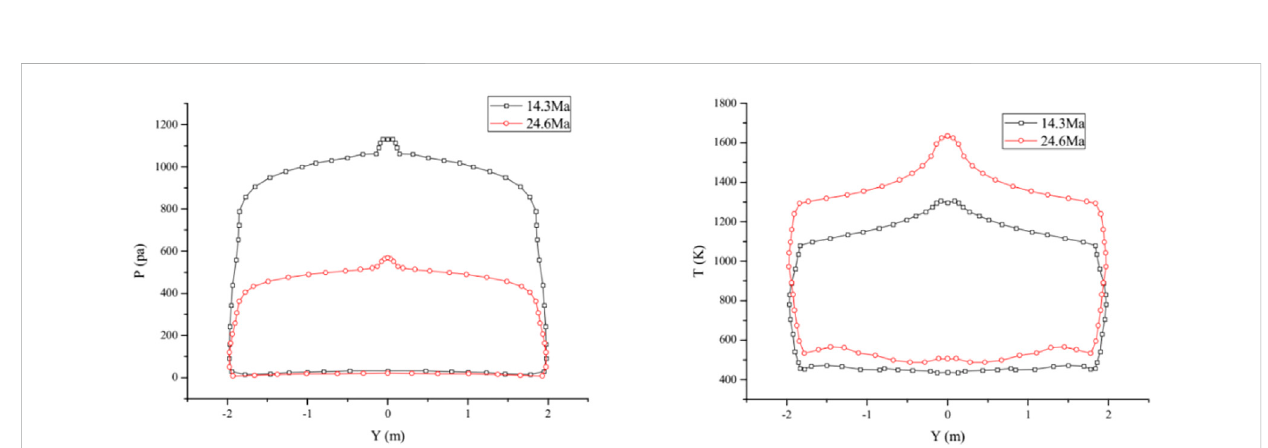
FIGURE 11 Meridional pressure and temperature distribution curves of fl exible in fl atable structure.